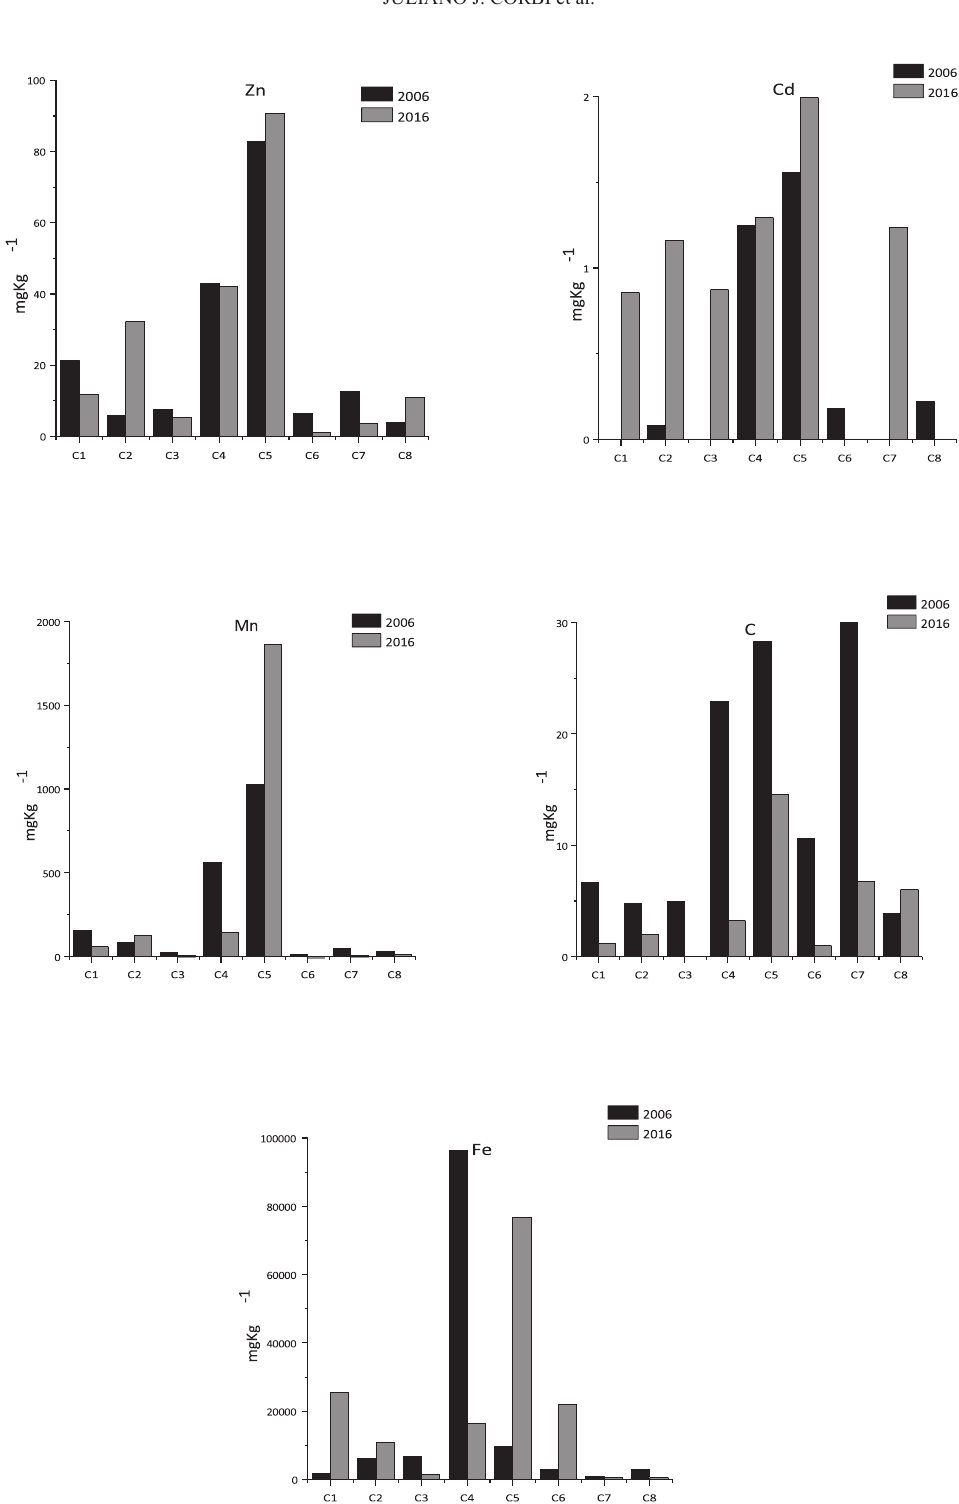
Figure 3 - Mean values of metal concentrations in 2006 and 2016 determined in sediments from the eight sampling sites. Streams C1 to C5 are located in sugarcane cultivation areas. Strems C6 to C8 are located in preserved areas. Streams detailed information in Table